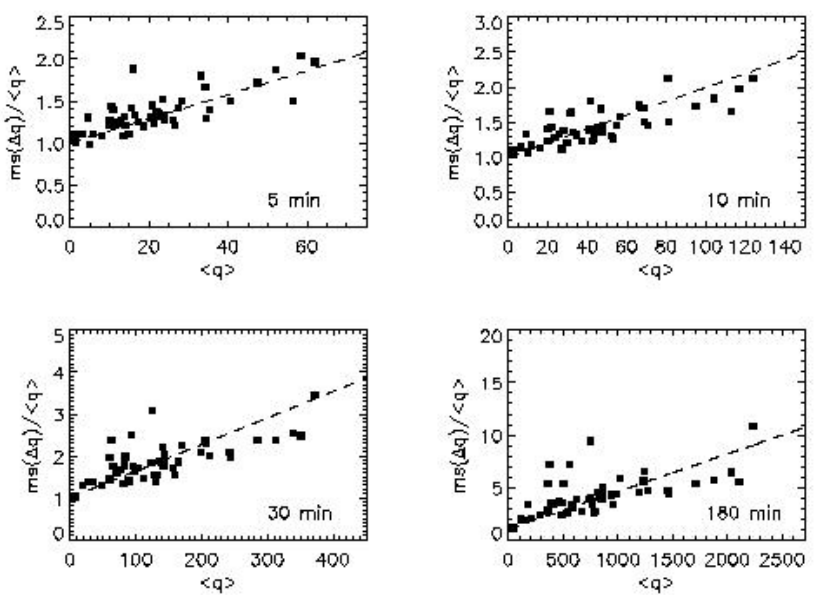
Figure 7. The relation between noise and systematic variations. The y value should be equal to 1 when all the variation is Poisson noise. The slope of the dashed line therefore gives an indication for the average relative systematic variation. Results are shown for 5 minute (top left), 10 minute (top right), 30 minute (bottom left) and 180 minute time-series (bottom right). The symbols represent link values. The dashed lines are eye-ball fits through the